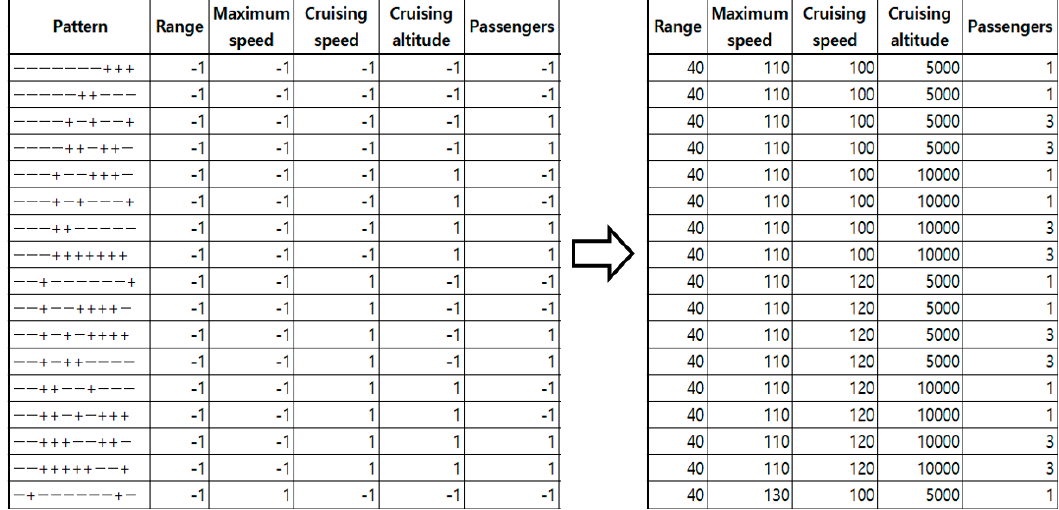
Figure 12. Screening test graph.